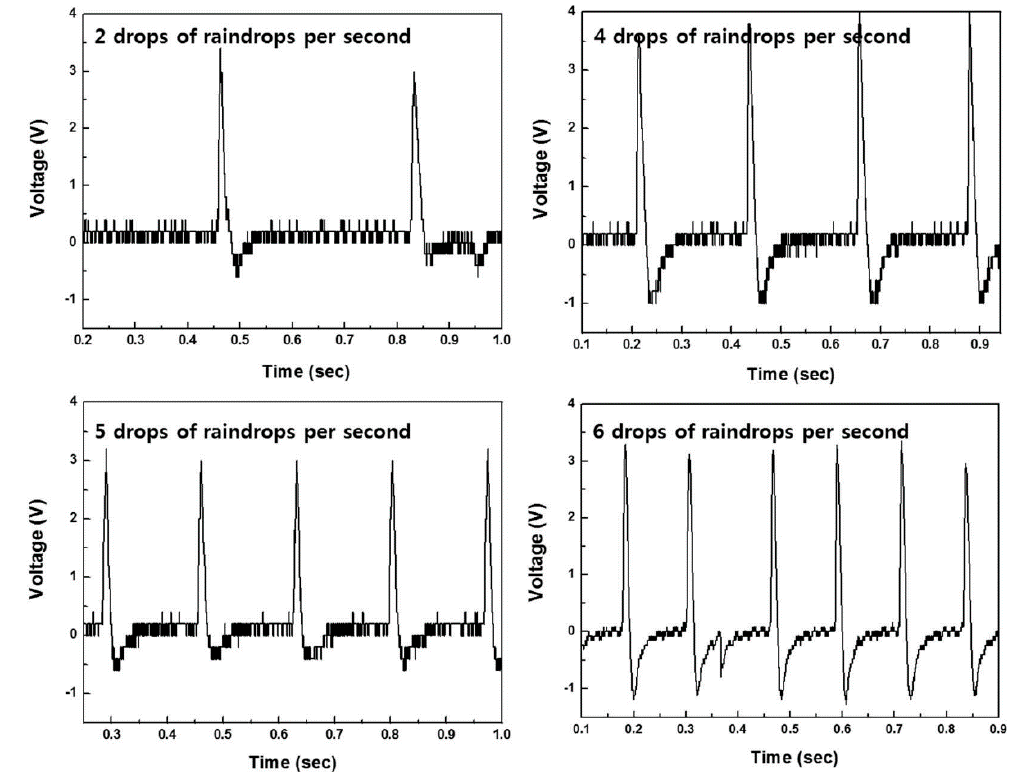
Figure 3. Number of rain drop results per second using measured voltage signal by WMAT in various environments from 2 to 6 of rain